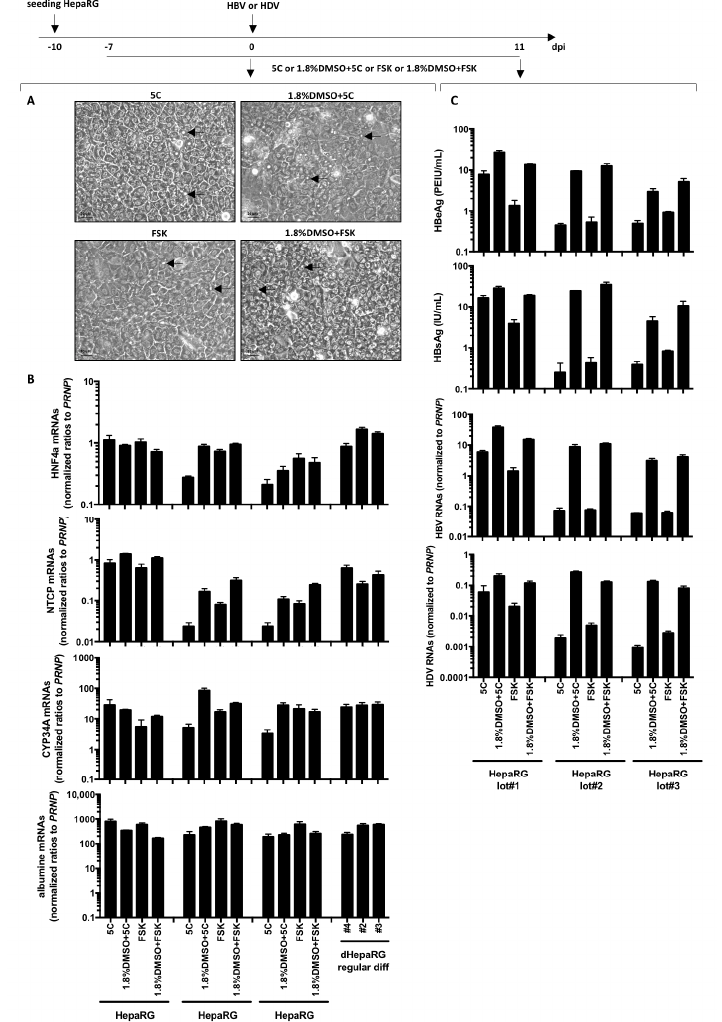
Figure 3. Fast di ff erentiation of HepaRG with chemicals. HepaRG were seeded at low density and treated with 5C, 5C complemented to 1.8% DMSO, FSK or FSK complemented to 1.8% DMSO when confluency was just reached. ( A ) Seven days later, cells were observed by phase contrast microscopy allowing to distinguish refractive bright / white bile canaliculi indicated with arrows on photographies. ( B ) Cells were harvested, and total RNA were extracted. Expression of the indicated hepatocytes di ff erentiation markers was analyzed by RT-qPCR and levels compared to HepaRG di ff erentiated with the regular protocol. ( C ) Cells were infected by HBV or HDV with a multiplicity of infection of 500 vge / cells or 50 vge / cells, respectively. At day 11 post-infection, supernatants were collected and levels of HBeAg and HBsAg analyzed by ELISA. Cells were harvested, RNA extracted and levels of HBV or HDV RNAs were analyzed by RT-qPCR. Results from three independent experiments with three di ff erent batches of HepaRG cells are shown and bars are the means +/ − SD of three biological replicates per